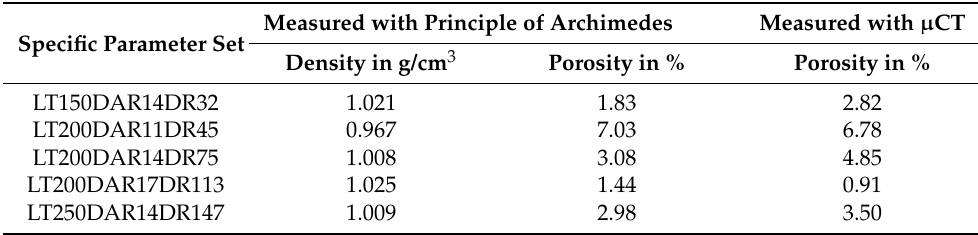
Table 4. Measured density and porosity for the specific parameter sets from Table 2. With the help of the bulk density of ABS, the measured density is converted into a